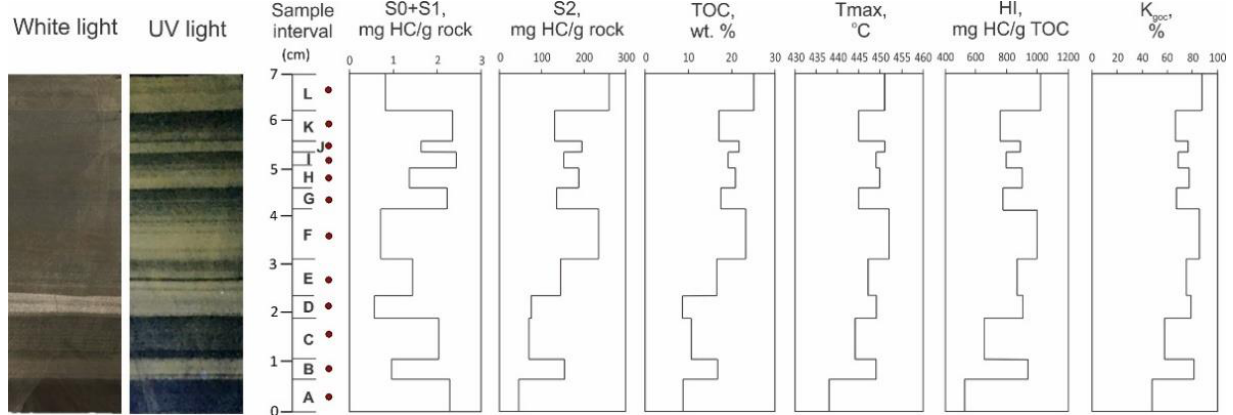
Figure 7. Detailed (layer-by-layer) Rock-Eval pyrolysis for core sample with interbedding of the alginite-rich layer and hosting organic-rich siliceous rock from well V-K 81. A–L, sampling